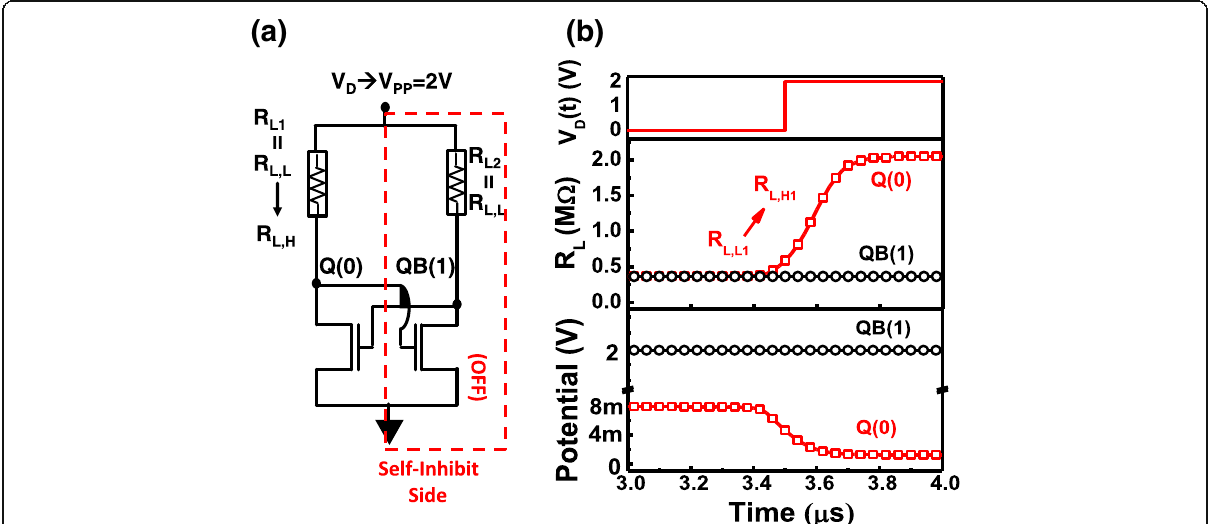
Fig. 9 a Illustration of self-inhibit mechanism during non-volatile data write by resetting one side of two RRAMs. b Dynamic change of R L and Q, QB potential verify self-inhibit write of latch data to RRAMs